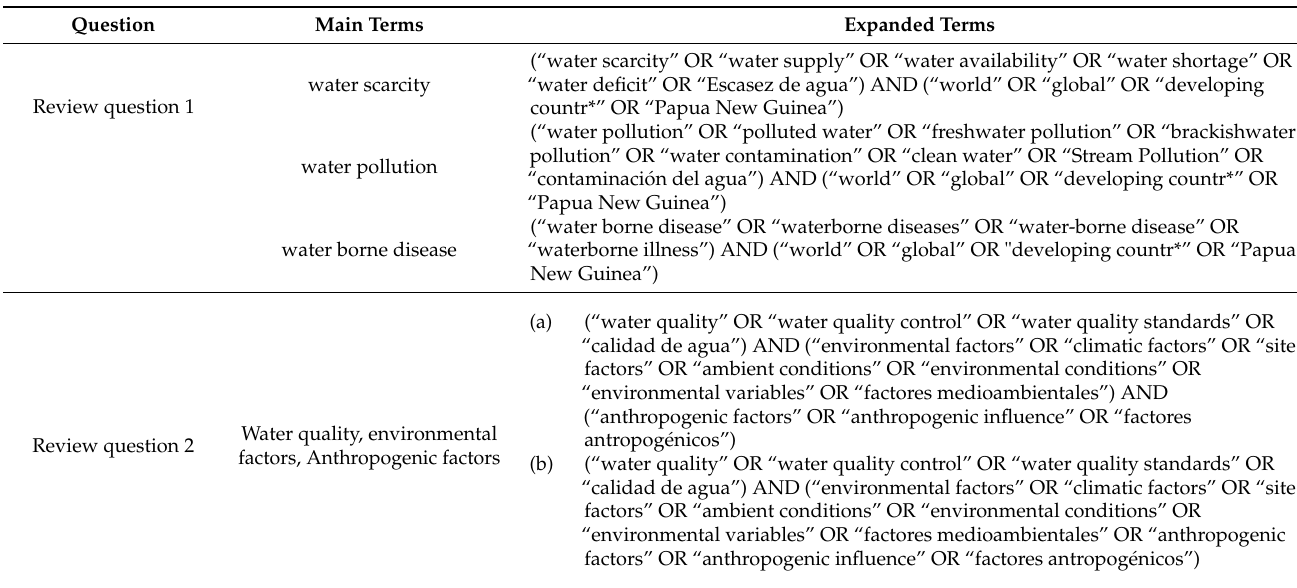
Table A2. Search strings with expanded